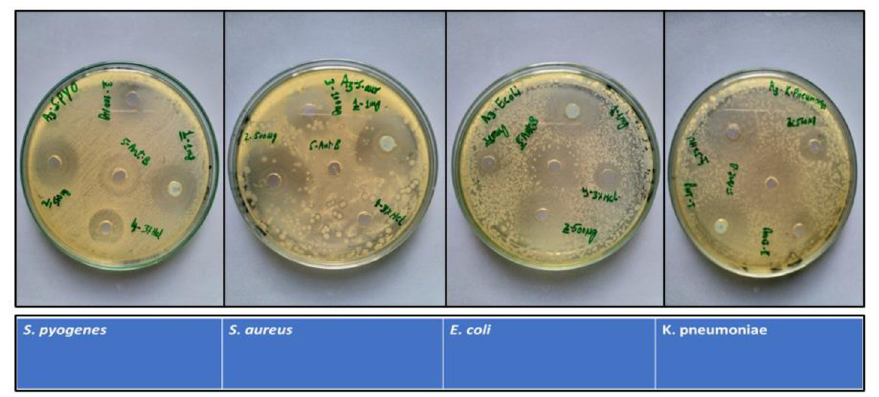
Fig 6. Zone of inhibition formed by Cu-doped ZnO-NPs against different bacteria.